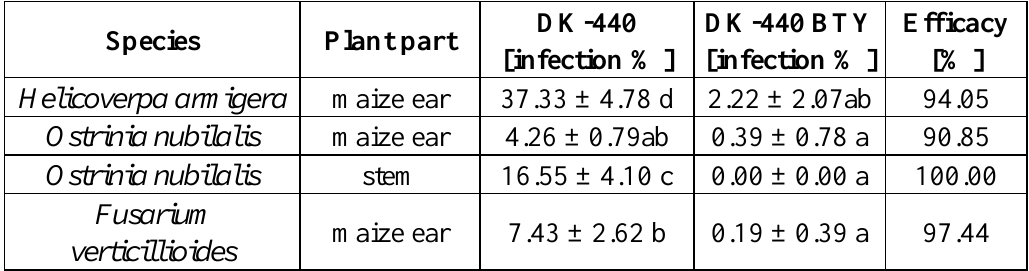
Table 7. Efficacy of MON 810 maize (DK-440 BTY) on Helicoverpa armigera , Ostrinia nubilalis and Fusarium verticillioides